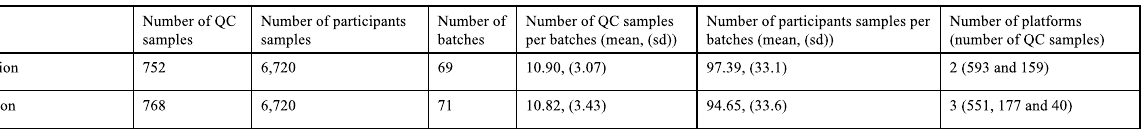
Figure 1. Overview of Study